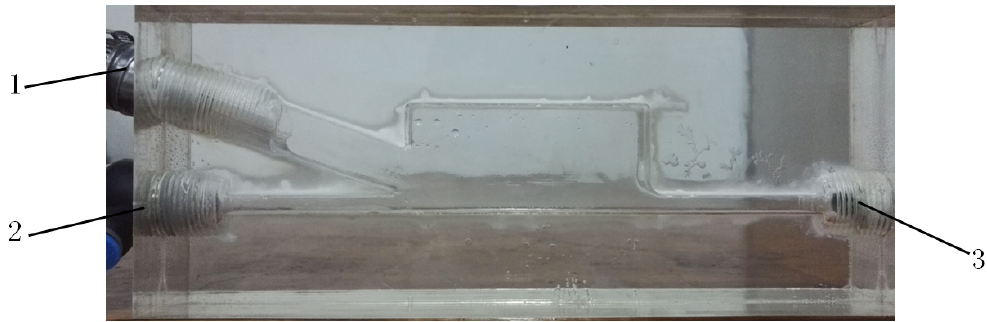
Figure 16. PIV observation flow channel: 1. particle flow inlet, 2. micro-nano-bubble inlet, 3. outlet.